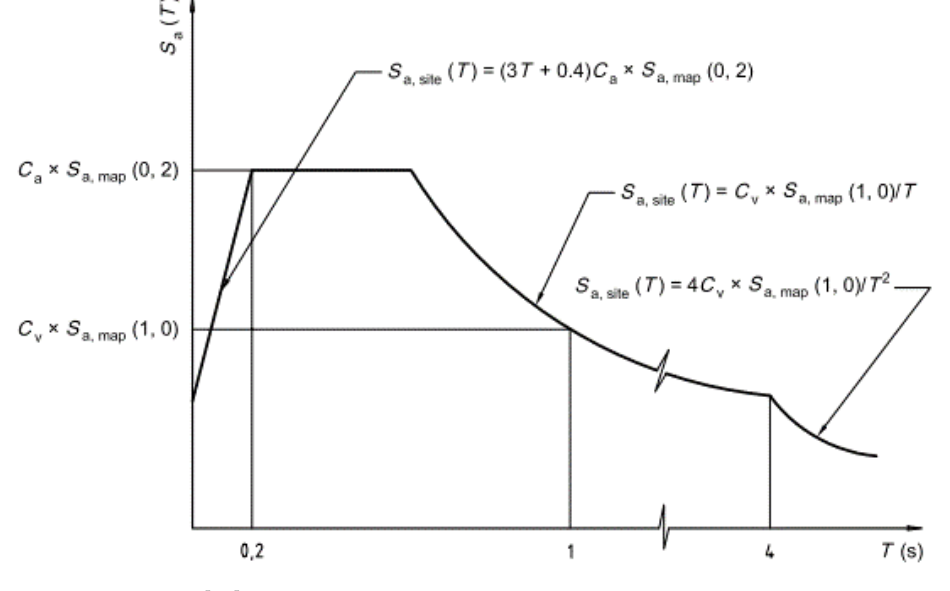
Figure 2. Damping [26].